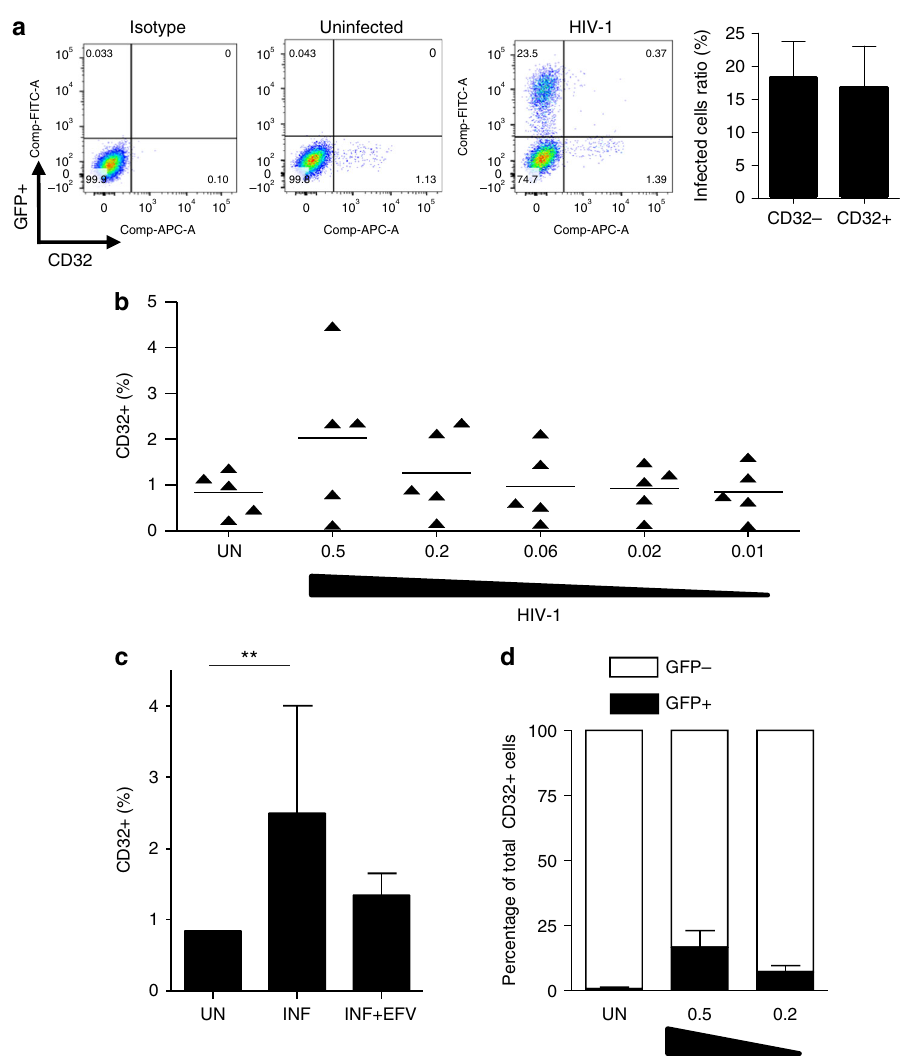
Fig. 3 CD32 is upregulated after productive HIV-1 infection. a CD32 expression in PHA/IL-2 stimulated CD4 + T cells infected with HIV-1 (a representative donor out of 5 is shown). The right panel indicates the ratio of HIV + (GFP + ) to CD32 − or to CD32 + cells ( N = 5). b Percentage of CD32 cell surface expression measured by fl ow cytometry and infected with different multiplicities of infection of HIV-1 NL4-3 or uninfected (UN). c Upregulation of CD32 expression after HIV-1 infection (INF) is reduced concomitant to blockade of HIV-1 infection with efavirenz (INF + EFV). d The percentage of HIV-1 + (GFP + ) cells in the CD32 + compartment. The data represent the mean ± SD of fi ve different